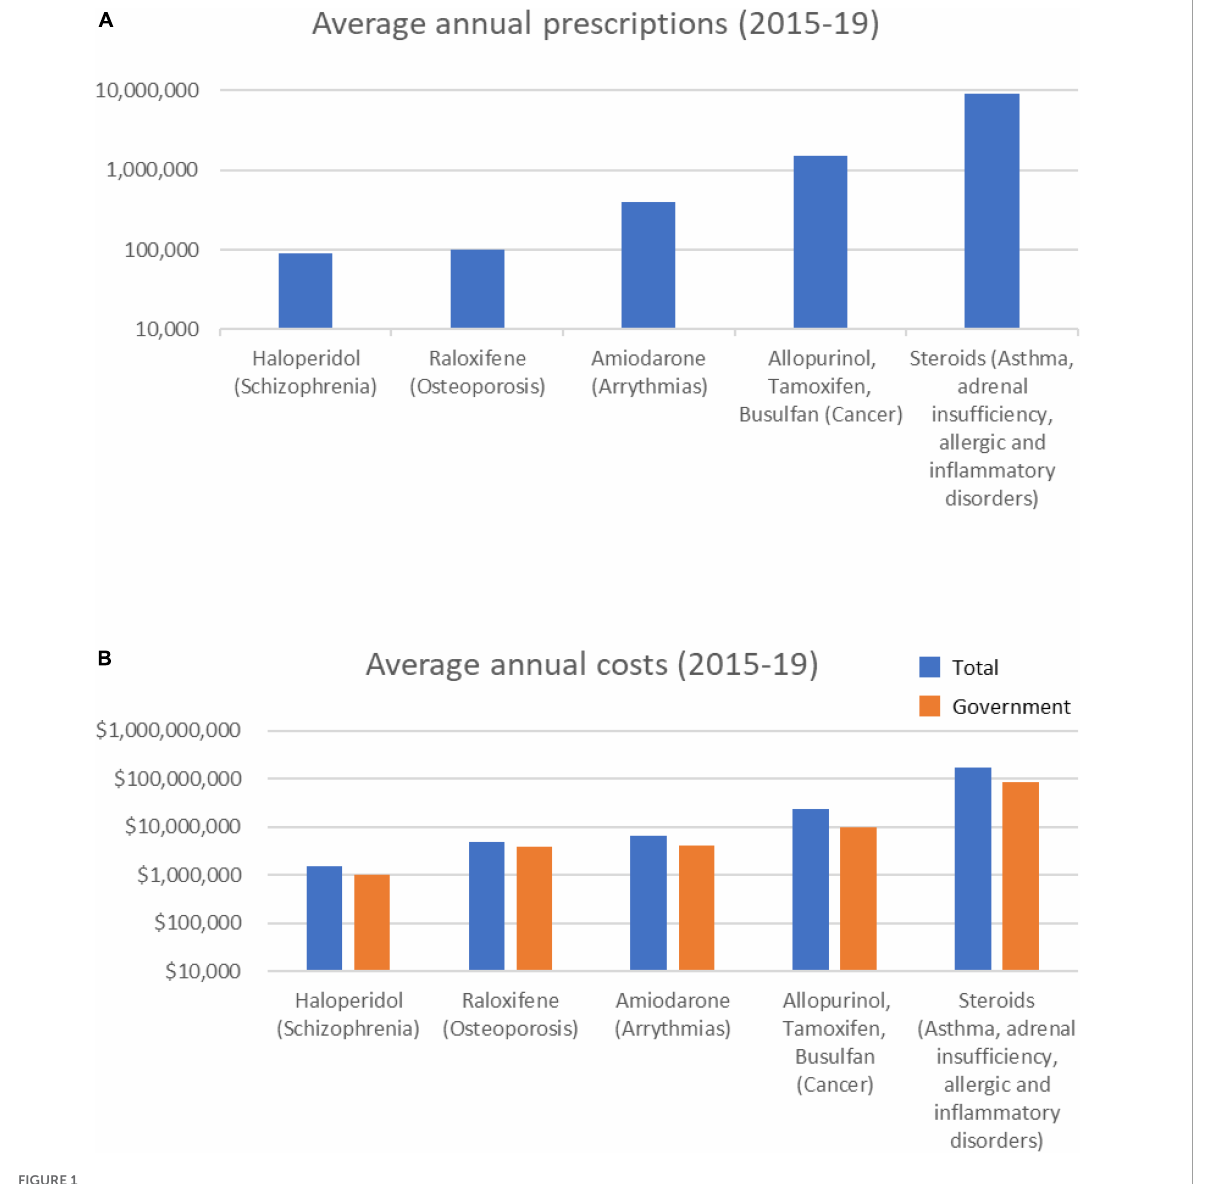
FIGURE1 Average annual prescription numbers (A) and costs (B) for members of the Known category of drugs associated with cataract, together with typical conditions for which they are prescribed.